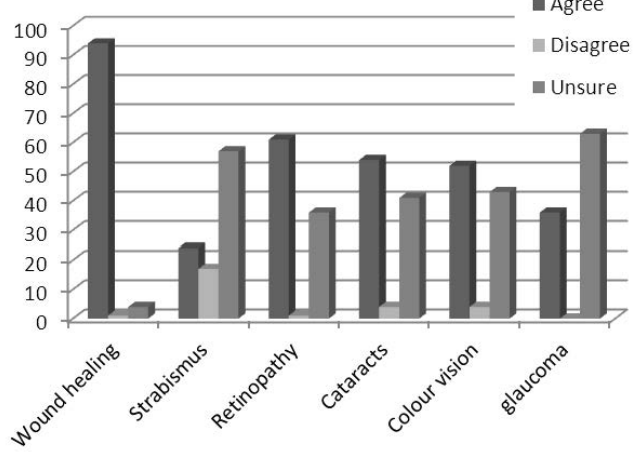
Figure 1: Respondents’ knowledge of the ocular effects of